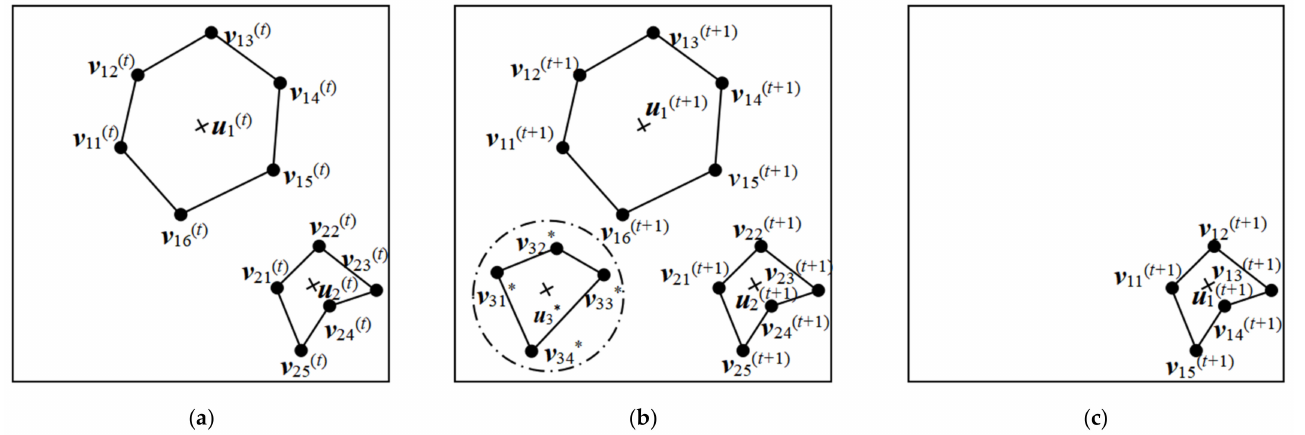
Figure 2. The examples of adding and deleting a polygon: ( a ) Configuration w ( t ) of object; ( b ) Add a polygon; ( c ) Delete a